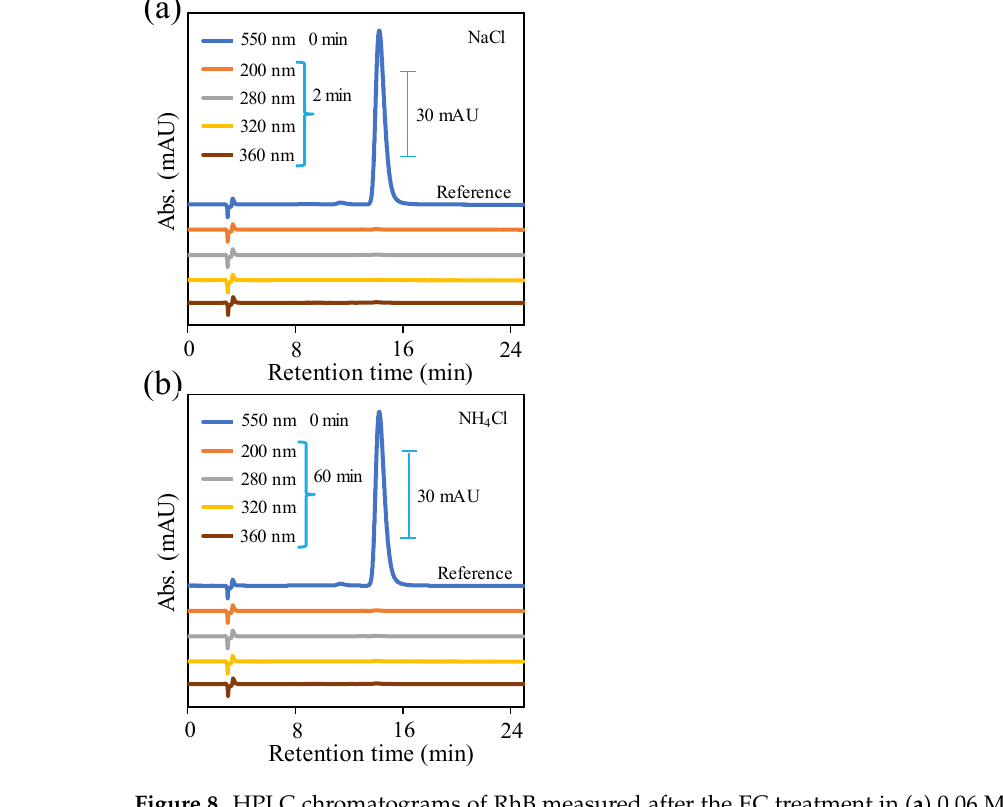
Figure 8. HPLC chromatograms of RhB measured after the EC treatment in ( a ) 0.06 M NaCl after 2 min test with different λ det and ( b ) 0.06 M NH 4 Cl measured after 60 min at different λ det , using 1 × 10 − 5 M RhB aqueous solution as the reference.